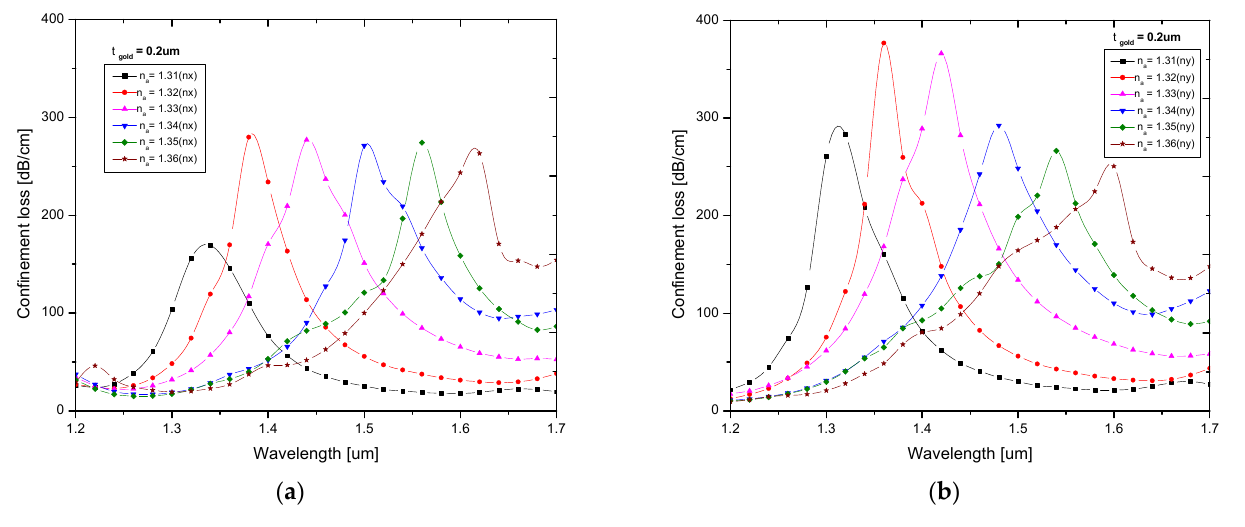
Figure 5. Confinement loss characteristics with respect to wavelength for RI ranges of 1.31–1.36 for ( a ) X-polarization and ( b ) Y-polarization.